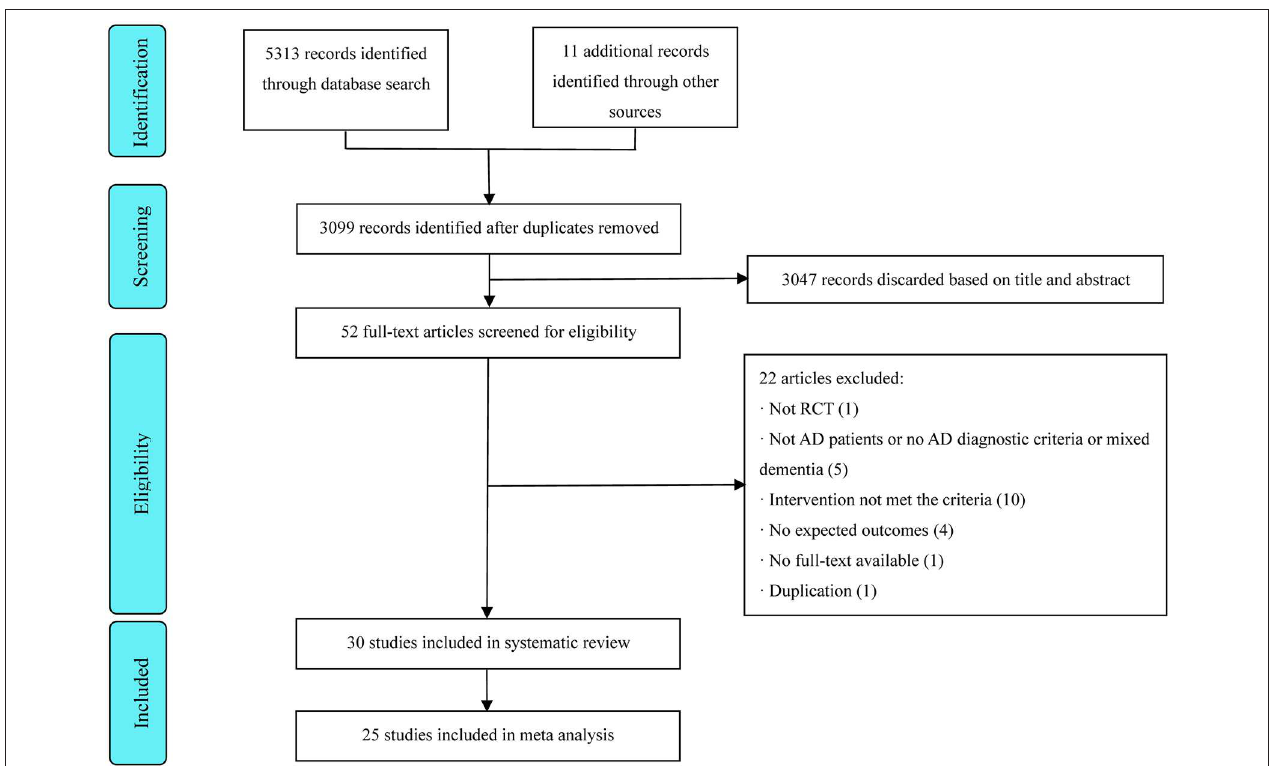
FIGURE 1 | Flow diagram of the study identification and selection process.